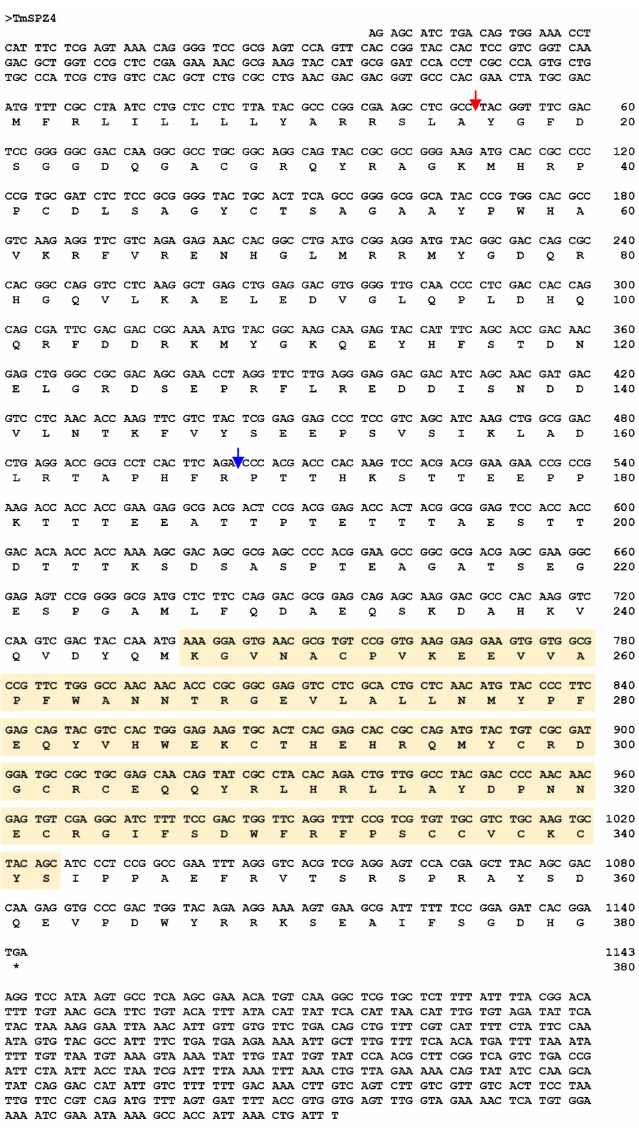
Figure 1. Nucleotide and deduced amino acid sequence of TmSpz4. TmSpz4 contains a 1143 bp open reading frame encoding a predicted polypeptide of 380 amino acid residues. Domain analysis showed that Tm Spz4 includes one cystine-knot domain (yellow box), one signal peptide region (red arrow), and one cleavage site (blue